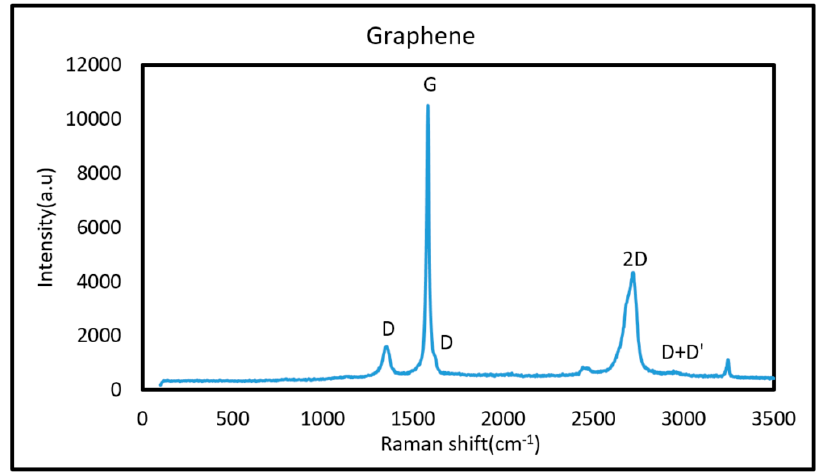
Figure 2. Raman spectroscopy of graphene nano particles.